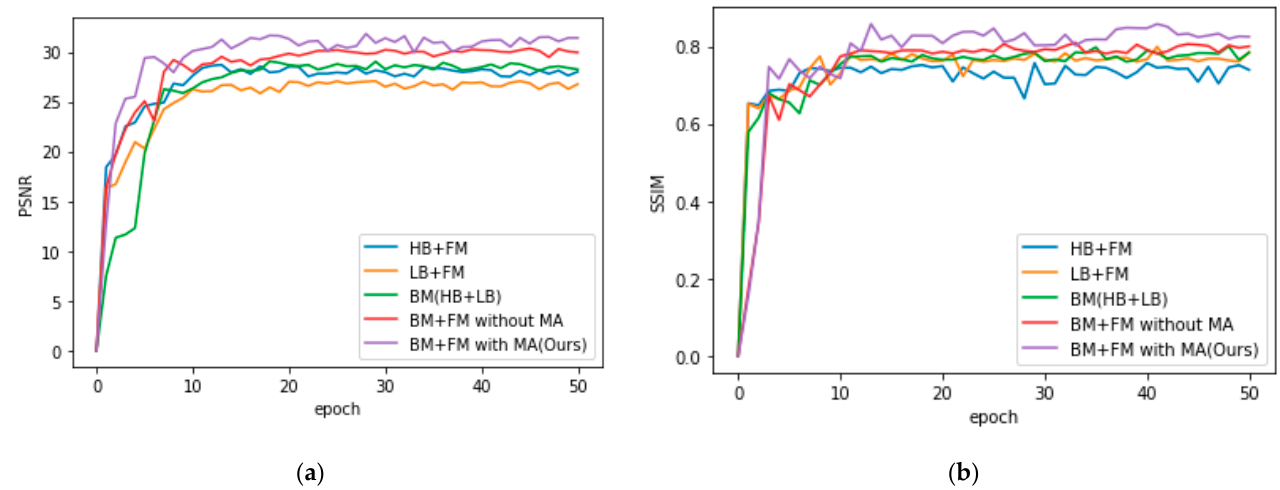
Figure 9. Ablation experiment results on test set. ( a ) PSNR scores of different structures. ( b ) SSIM scores of different structures.